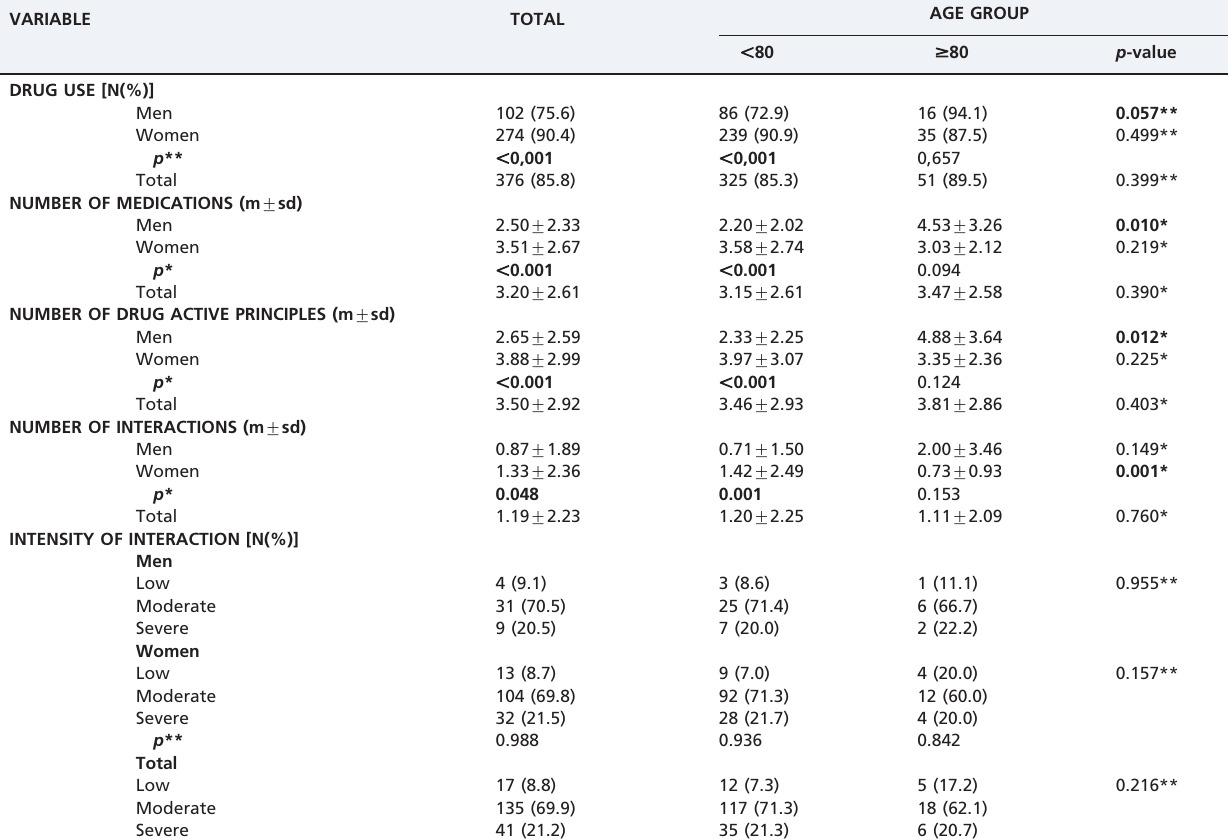
Table 1 - Drug use and intensity of interaction in the elderly, according to gender and age group (N= 438).